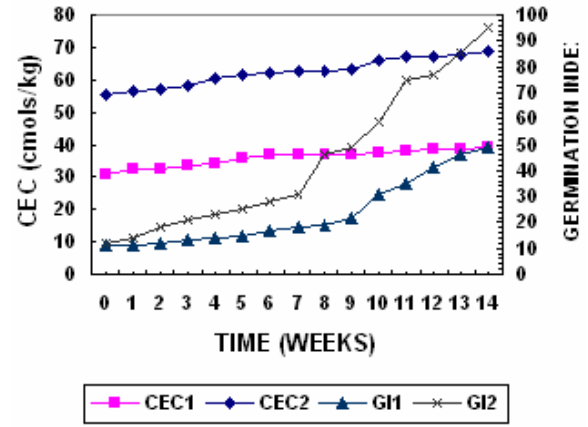
Fig 8: Variation of Humification Index & Humification Ratio during